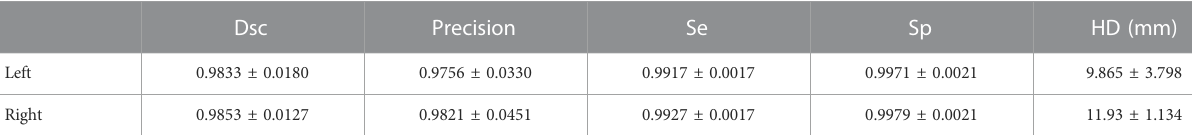
TABLE 1 Results of segmentation of the right and left lung parenchyma.